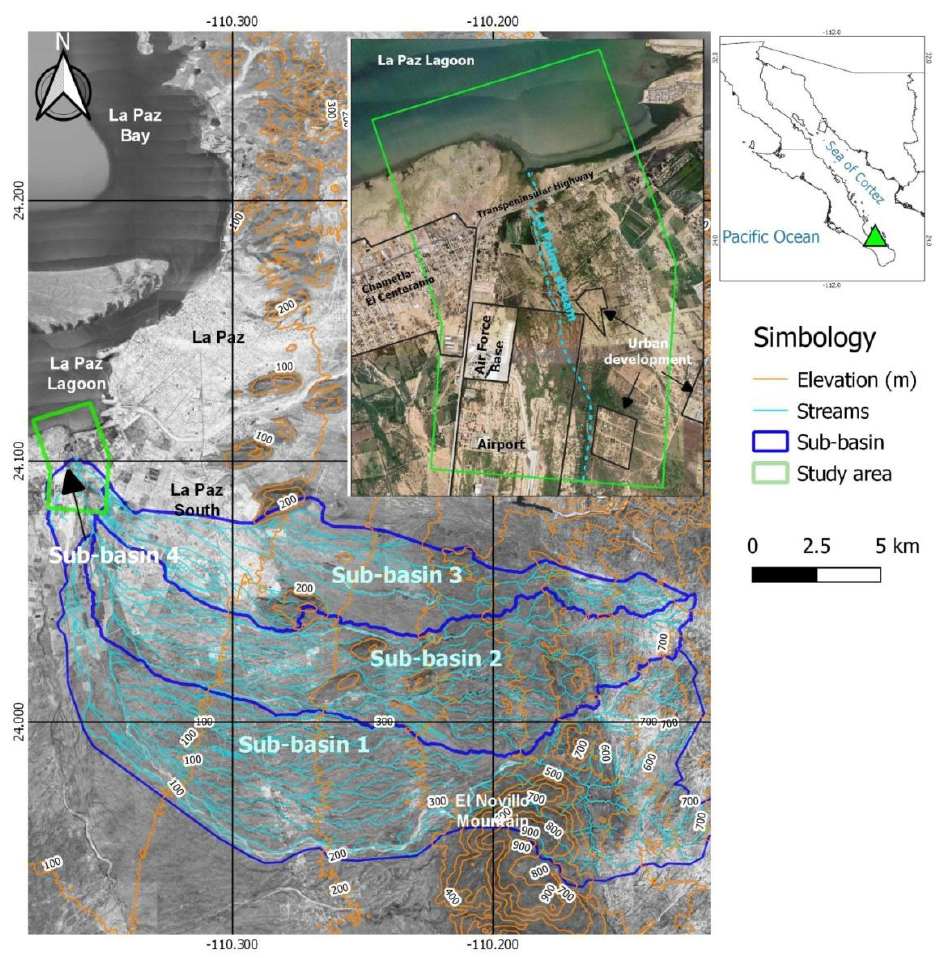
Figure 1. Localization of study area.